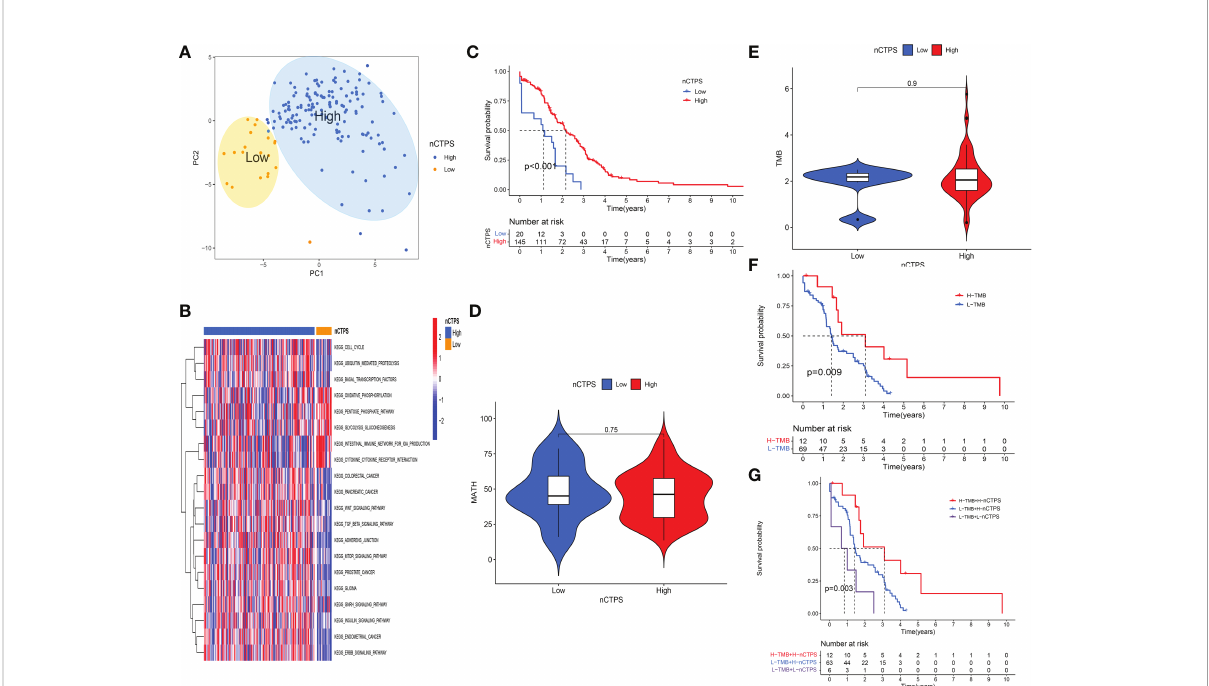
FIGURE 4 Evaluation of the speci fi c role of therapeutic relevant genes in the TCGA cohort. (A) Kaplan-Meier curves showed the overall survival difference between high and low nTCPS groups ( p < 0.001). (B) The GSVA analysis between high and low nTCPS groups. Red and blue represented relative enrichment degree of activated and inhibited pathways, respectively. (C, D) There were no signi fi cant differences in TMB ( p = 0.9) (C) and MATH ( p = 0.75) (D) between high and low nTCPS groups. (E) PCA scatter plot showed that two groups of patients can be separated by the PCA clustering analysis. (F) Kaplan-Meier curves showed the overall survival difference between high and low TMB groups ( p = 0.009). (G) The strati fi ed prognostic analysis showed that the synergistic effect of the TMB and nTCPS on the prognosis ( p =